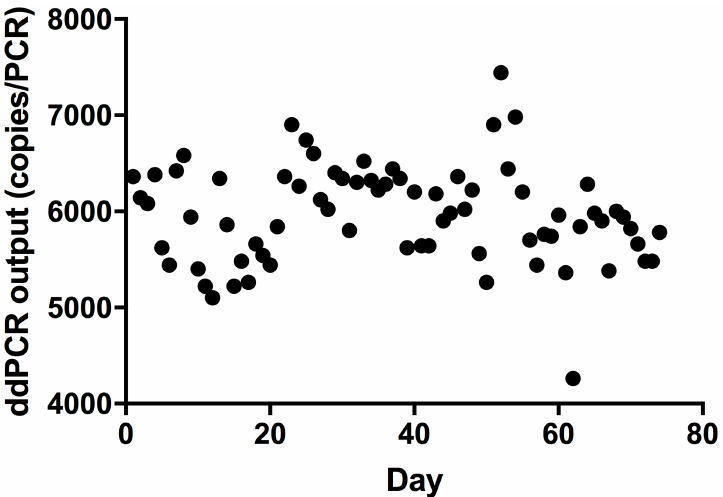
Fig 4. Internal validation of ddPCR for quantification of bovine DNA in a fortified poultry meal feed sample. The results were obtained from 74 consecutive runs conductedon different days. The variation(RSD %) was 8.6.